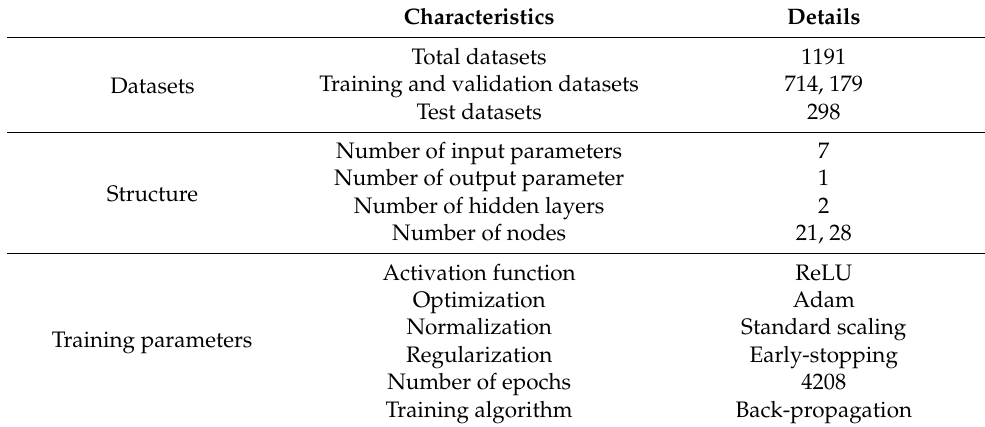
Table 5. Characteristics of the ANN